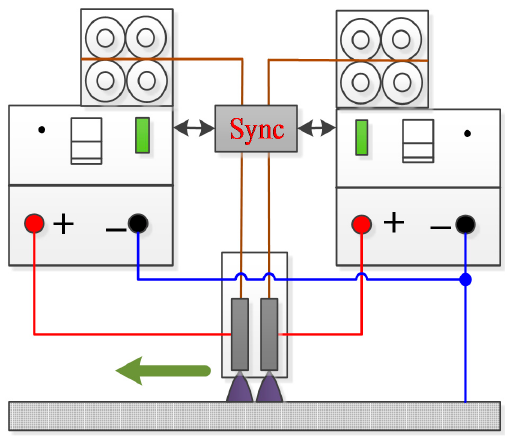
Figure 1. Schematic figure of double-wire metal inert-gas (MIG) arc welding.